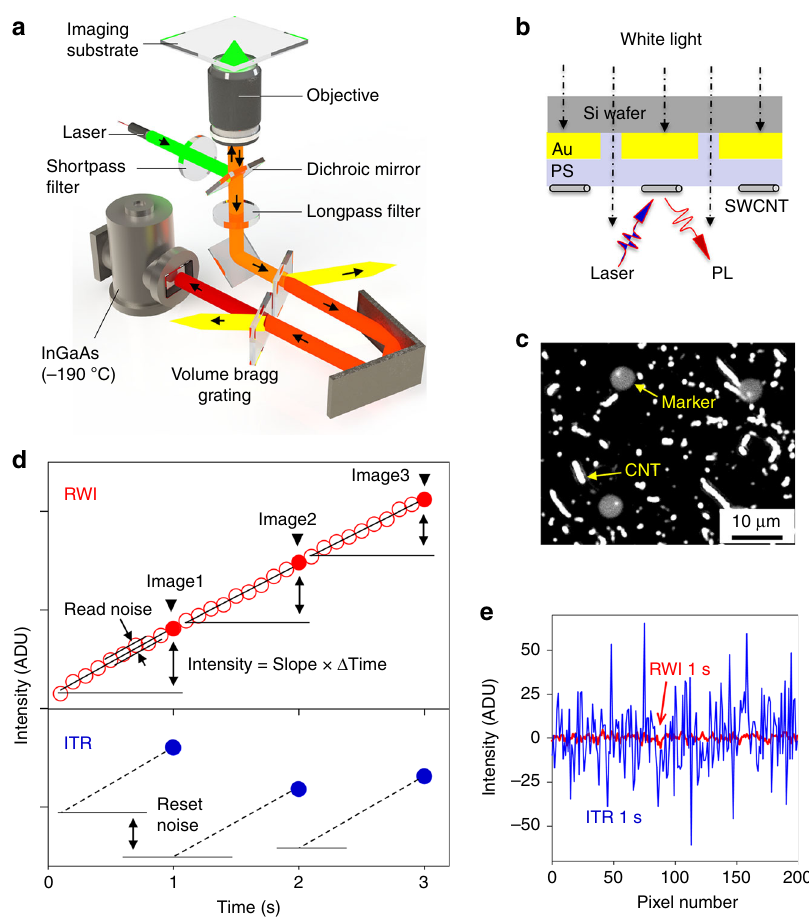
Fig. 2 Single-defect spectroscopy set-up. a Schematic of the system, which integrates a volume Bragg grating for hyperspectral imaging and an InGaAs 2D array detector that operates at − 190 °C to signi fi cantly suppress the dark current in the shortwave IR. b Schematic of the imaging substrate that incorporates Au-on-Si markers and polystyrene (PS) insulating layer for drift correction in the shortwave IR. c A PL image with both SWCNTs and the markers simultaneously resolved. Note that nanotubes with length smaller than the diffraction limit (~600 nm for a numerical aperture 0.85 objective collecting emission at 1000 nm) appear as white dots in the image. d The comparison of signals of the same pixel from an image sequence captured by the integrate-then-read (ITR, blue fi lled circles) and read-while-integrate (RWI, red empty circles) demonstrates the working principle of non-destructive RWI mode. The integration slopes for different images in ITR (dashed lines) do not have identical starting point, caused by reset noise. Unlike ITR, RWI does not reset the detector, thus eliminating the reset noise. For each image (red fi lled circles) in RWI, the noise can be further suppressed by linear regression of different data points to retrieve the integration slope (black solid line). e The comparison of background signals from images captured by the ITR (blue) and RWI (red). Under otherwise identical conditions, RWI demonstrates more than an order of magnitude lower noise level than ITR, with a standard deviation of merely 1.75 analog-digital unit (ADU) (vs. 18.5 ADU for ITR). Note that 0.168 ADU corresponds to one photon arriving at the